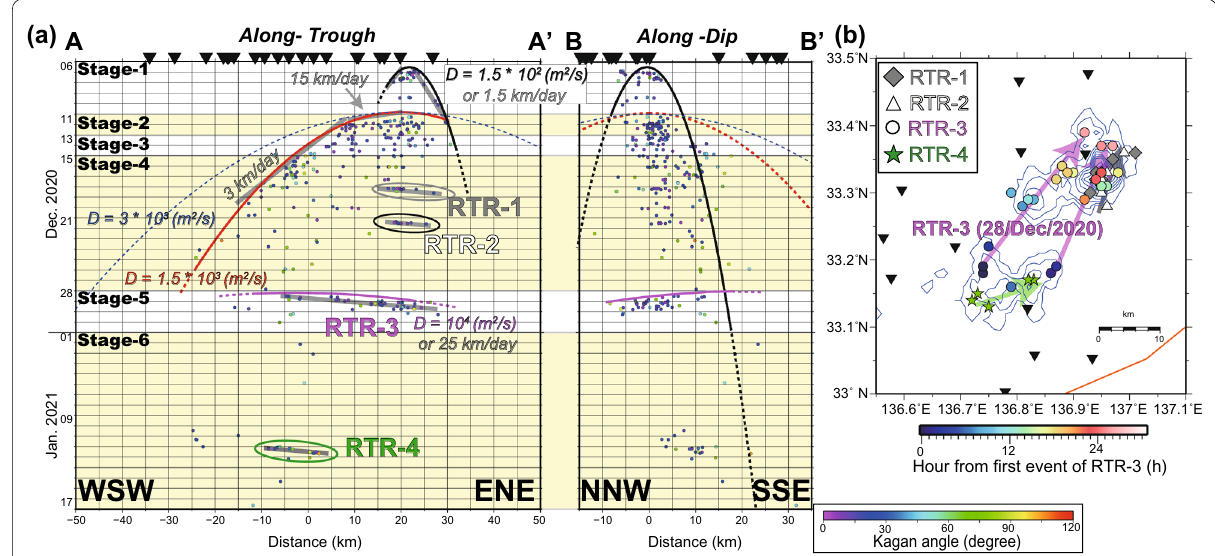
Fig. 3 Spatio-temporal distribution of the sVLFEs. a Along-trough and along-dip directions. The definition of these directions is presented in Fig. 1a. The white and yellow background colors indicate the periods of each stage. The circles indicate the projected locations of the sVLFEs with the color indicating the Kagan angle with respect to the reference focal mechanism shown in Fig. 1b. b Map view of the spatial distribution for rapid tremor reversals (RTRs) with different symbols for each episode. Only sVLFEs with Kagan angles with respect to the reference focal mechanism of less than 30° are plotted. The color of the circles (RTR-3 events) indicates the elapsed time from the first RTR-3 event. Gray, pink, and green vectors indicate the approximate migration direction for RTR-1 and 2, RTR-3, and RTR-4, respectively. Other symbols are the same as in Fig.